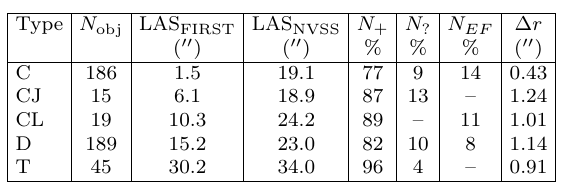
Table 1. Optical identification of the RCR catalogue by morphological types of radio